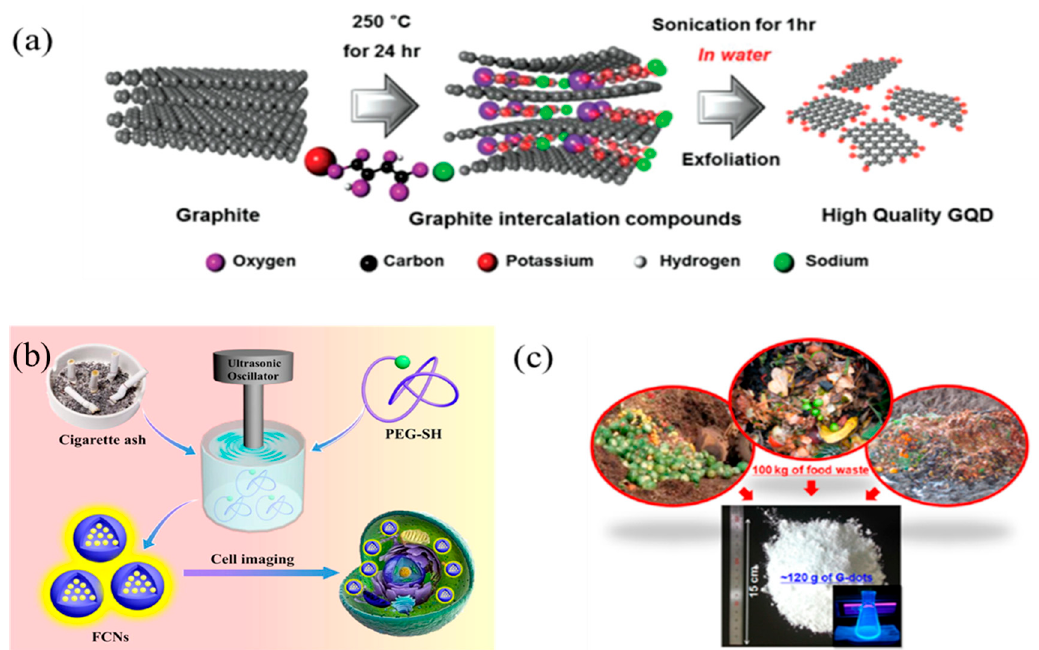
Figure 4. Schematic diagram of ( a ) Preparative strategy of GQDs [57]. Copyright 2014, John Wiley and Sons Inc. ( b ) Fabrication of polymer-functionalized CQDs by ultrasonic-assisted treatment [58]. Copyright 2018, Elsevier. ( c ) Synthesis and application of CDs derived from food waste [59]. Copyright 2014, American Chemical Society.